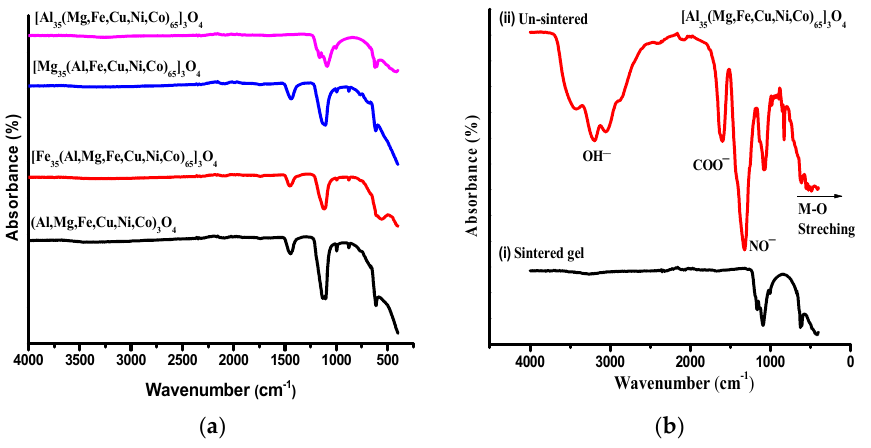
Figure 2. FTIR spectra of EHEOs ( a ), sintered (i) and un-sintered. (ii) [Al 35 (Mg, Fe, Cu, Ni, Co) 65 ] 3 O 4 NEHEO ( b ).